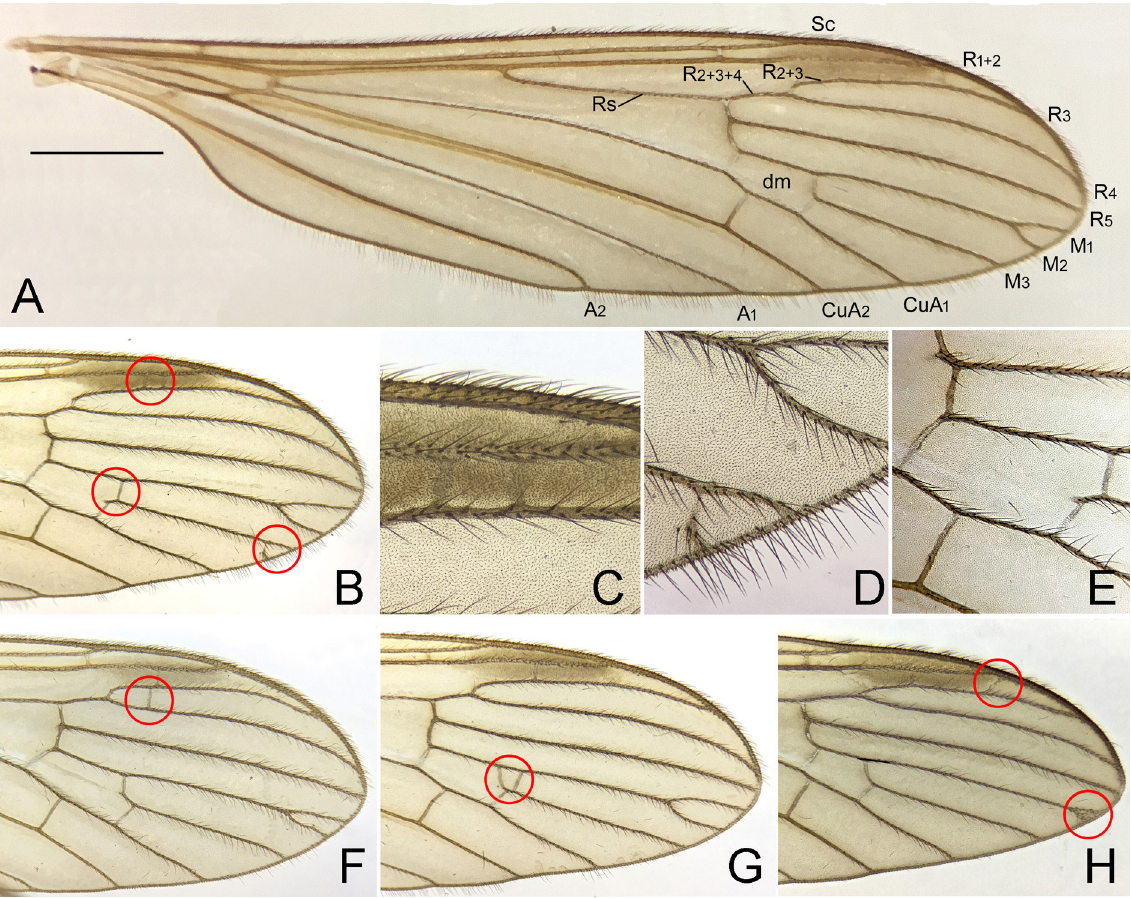
Fig. 3. Dicranophragma (B.) relictum Mederos sp. nov. A . Wing venation. B–H . Variations detected